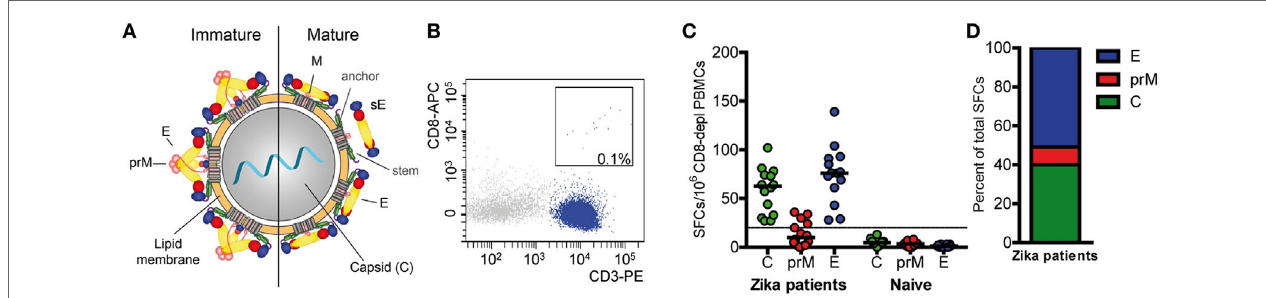
FigUre 1 | CD4 T cell responses to Zika virus infection. (a) Schematics of a flavivirus particle representing an immature (left) and mature (right) virion that comprises three structural proteins: C (capsid), prM (membrane), and E (envelope). (B) Representative FACS plot from CD8-depleted peripheral blood mononuclear cells (PBMCs). (c) Individual CD4 T cell responses to C, prM, and E from Zika patients and naïve individuals as determined in IL-2 ELISPOT assays. Results are given as spot-forming cells (SFCs). Medians are depicted as black lines. The dashed line represents the cutoff for assay positivity. (D) Percentage of spots contributed by C, prM, and E peptides in Zika patients.